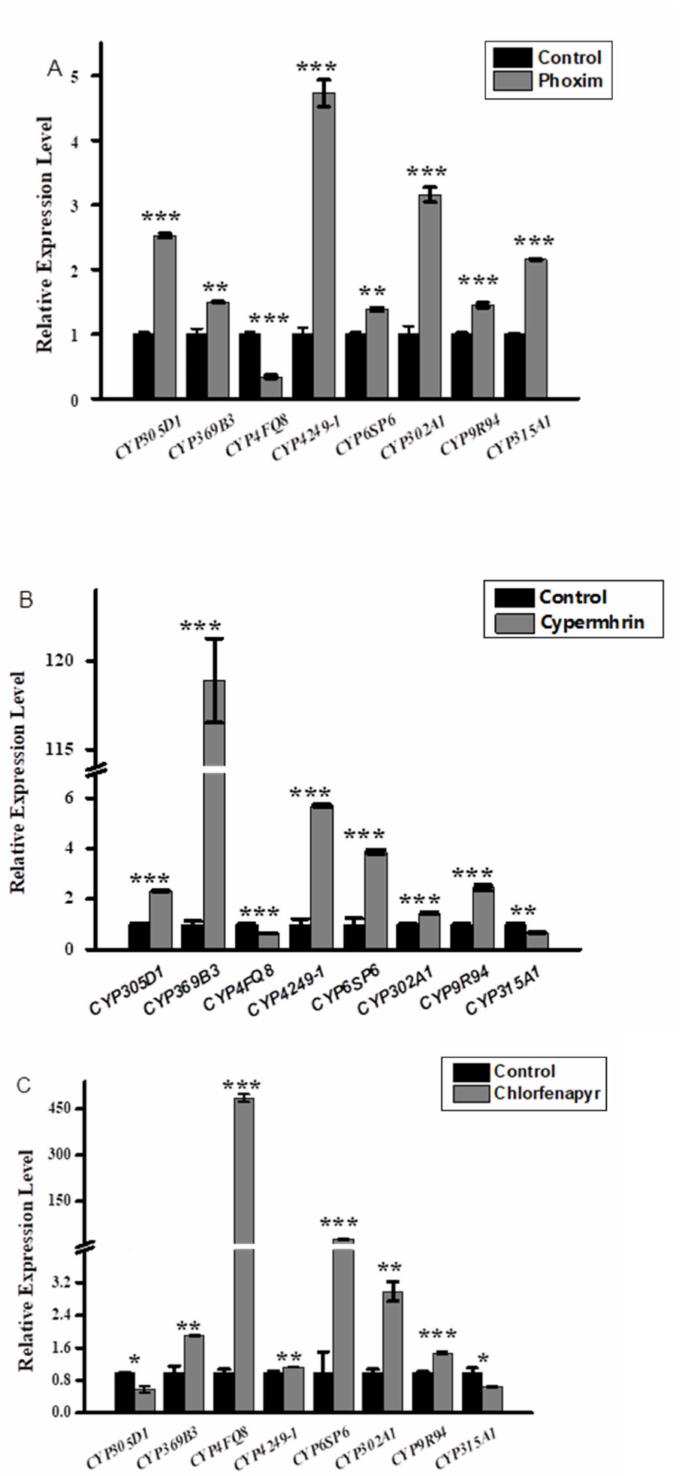
Figure 3. Relative expression profiles of MpulCYPs after phoxim ( A ), cypermethrin ( B ), and chlorfe- napyr ( C ) treatment. The transcriptional level of each gene in insecticide-treated individuals was normalized relative to that in acetone-treated (control) individuals. Asterisks indicates a signifi- cant difference in relative expression levels (one-way analysis of variance with Tukey’s post hoc test, * p < 0.05; ** p < 0.01; *** p < 0.001). Log transformation was applied to satisfy the hypothesis of